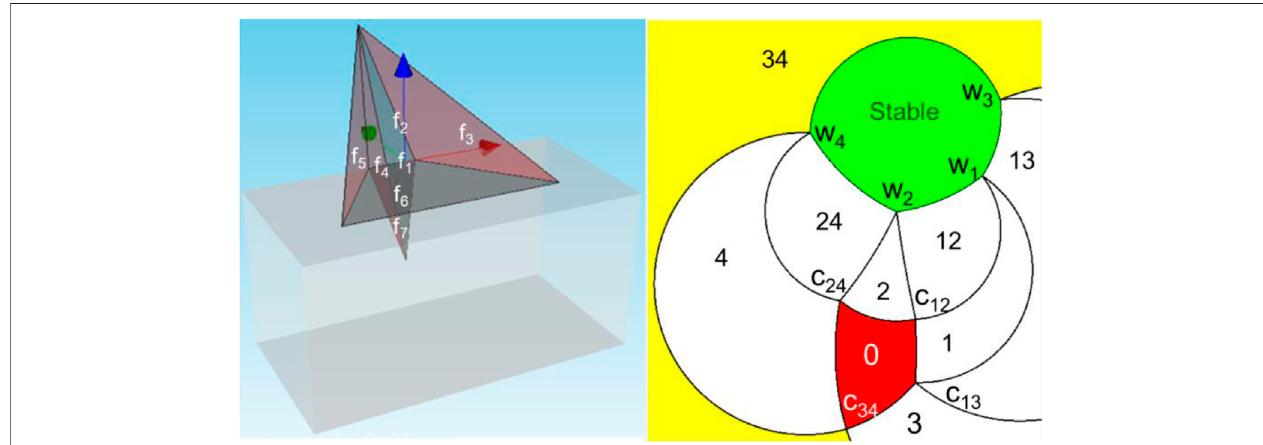
FIGURE 5 | Sliding Mode for a concave block on the edge of tunnel.